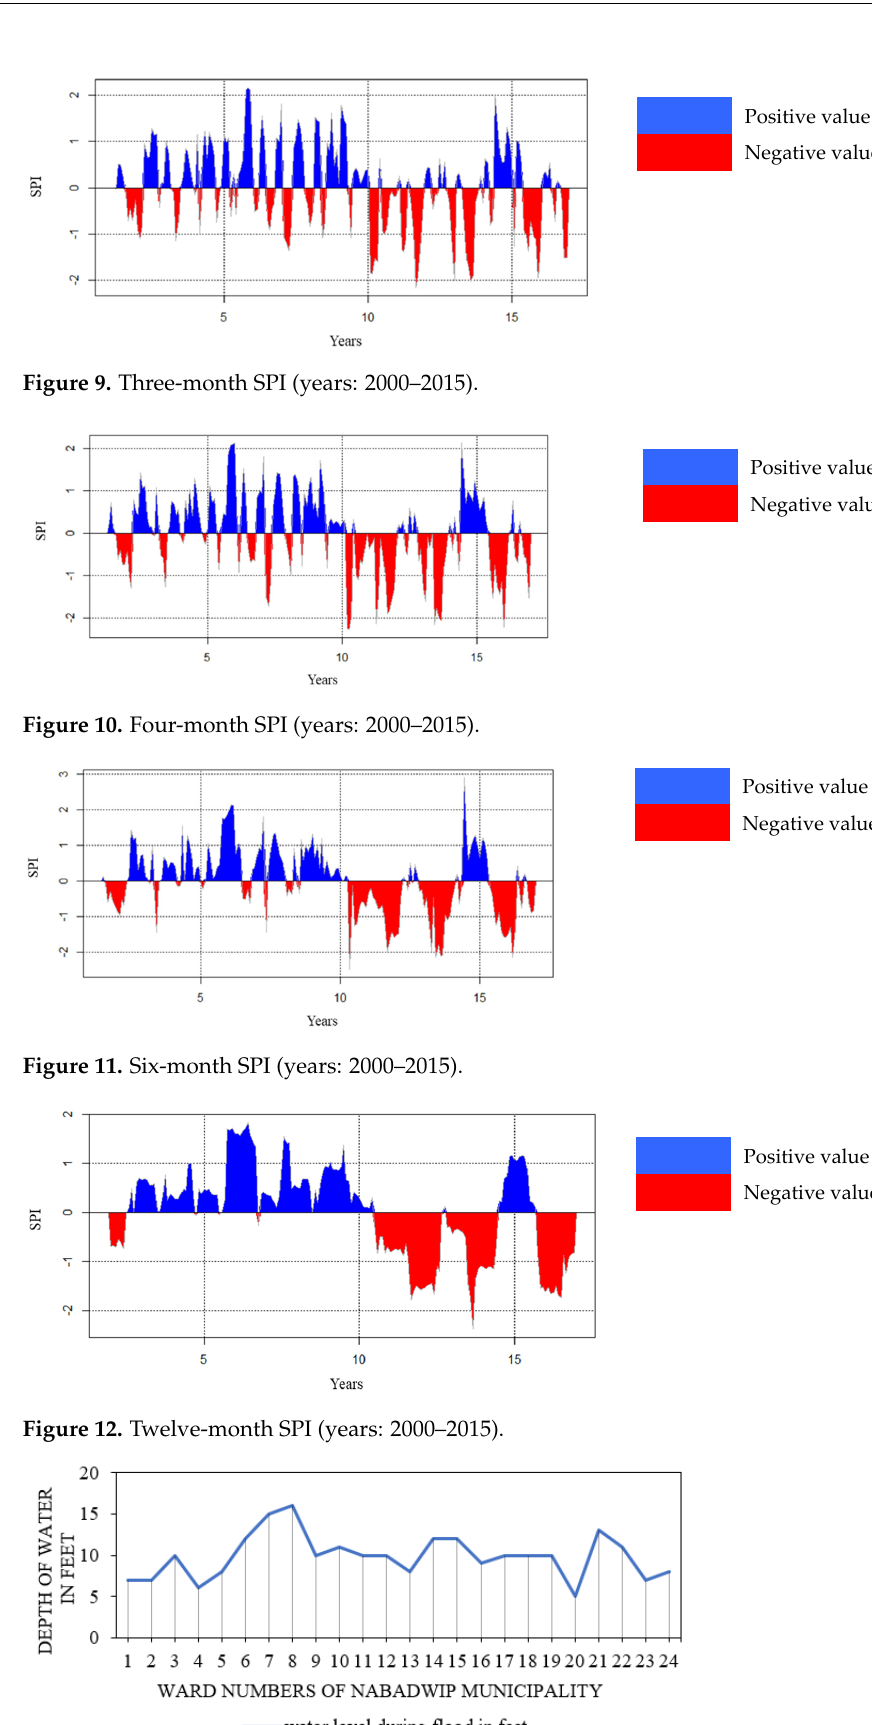
Figure 8. One-month SPI (years: 2000–2015).